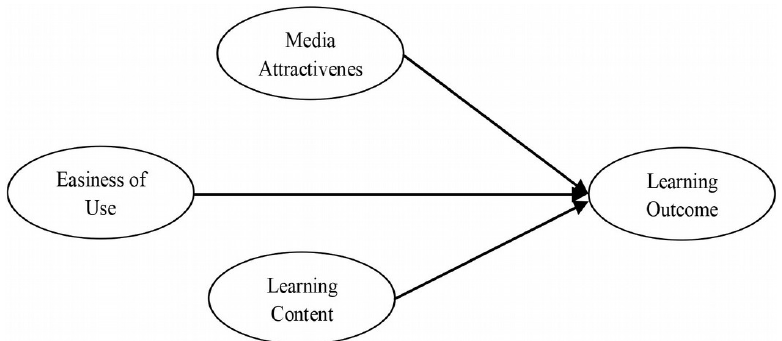
Figure 2. Modeling of utilizing signal coding technique based on GUI Simulation